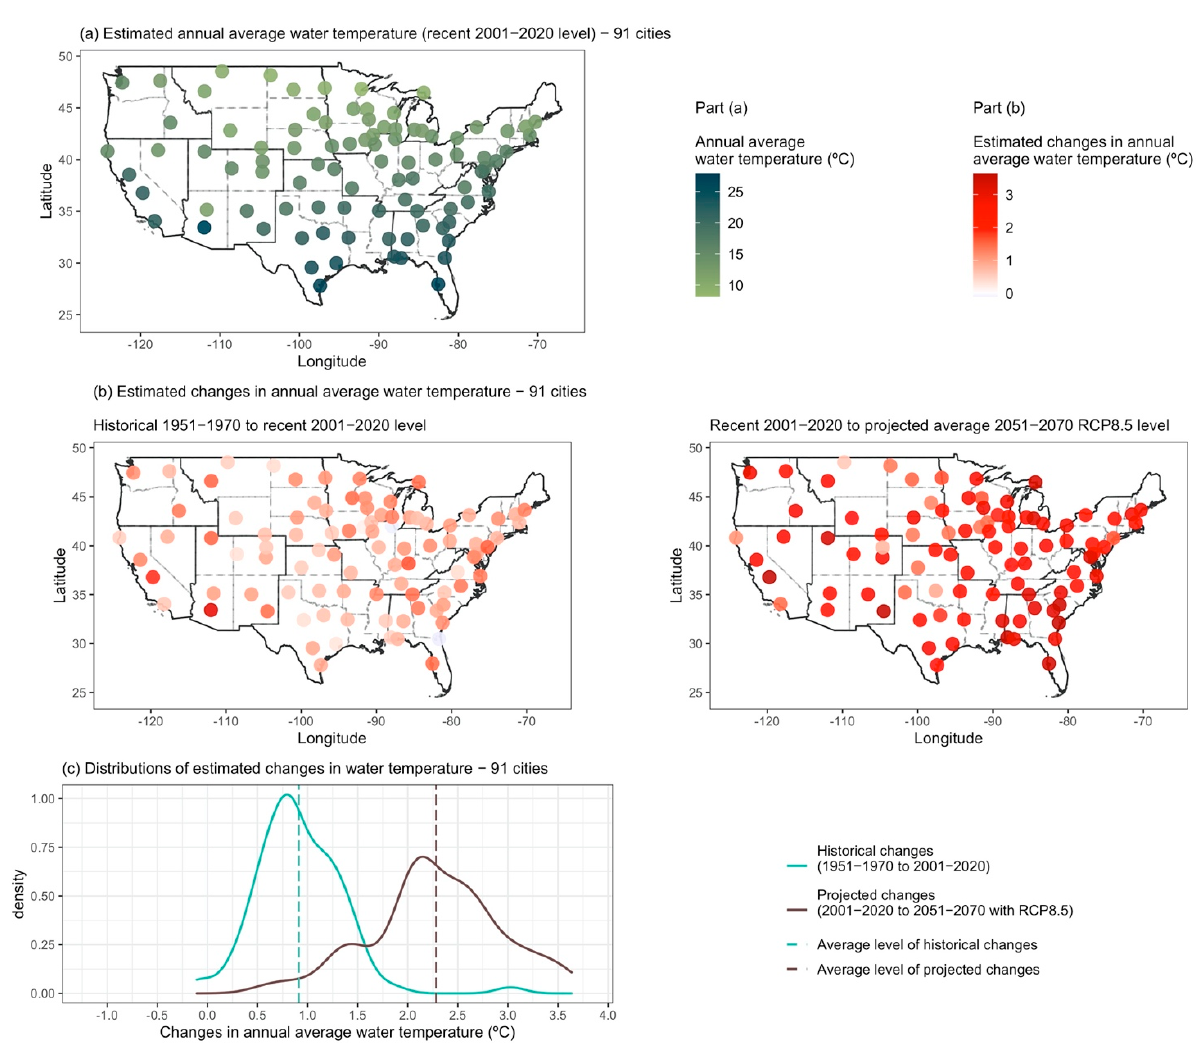
Figure 4. Annual average DWDS water temperature estimates and estimated water temperaure changes (with three separate 20 year periods) for the 91 U.S. cities with ( a ) the spatial distributions of the annual average water temperature estimates for the 91 cities (2001–2020 level); ( b ) the spatial distributions of the estimated changes in annual average water temperature between the two historical levels and from the recent 2001–2020 level to the projected 2051–2070 level; and ( c ) probability density functions (PDFs) of the estimated changes among the 91 cities. The standard parameter values of the NREL model were used. Solid lines around the boundaries of states in parts ( a ) and ( b ) show the nine NOAA climate regions [73].